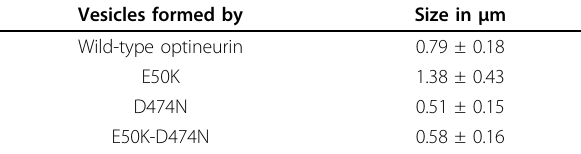
Table 1 Sizes of vesicles formed by optineurin and its mutants Vesicles formed by Size in μ m Wild-type